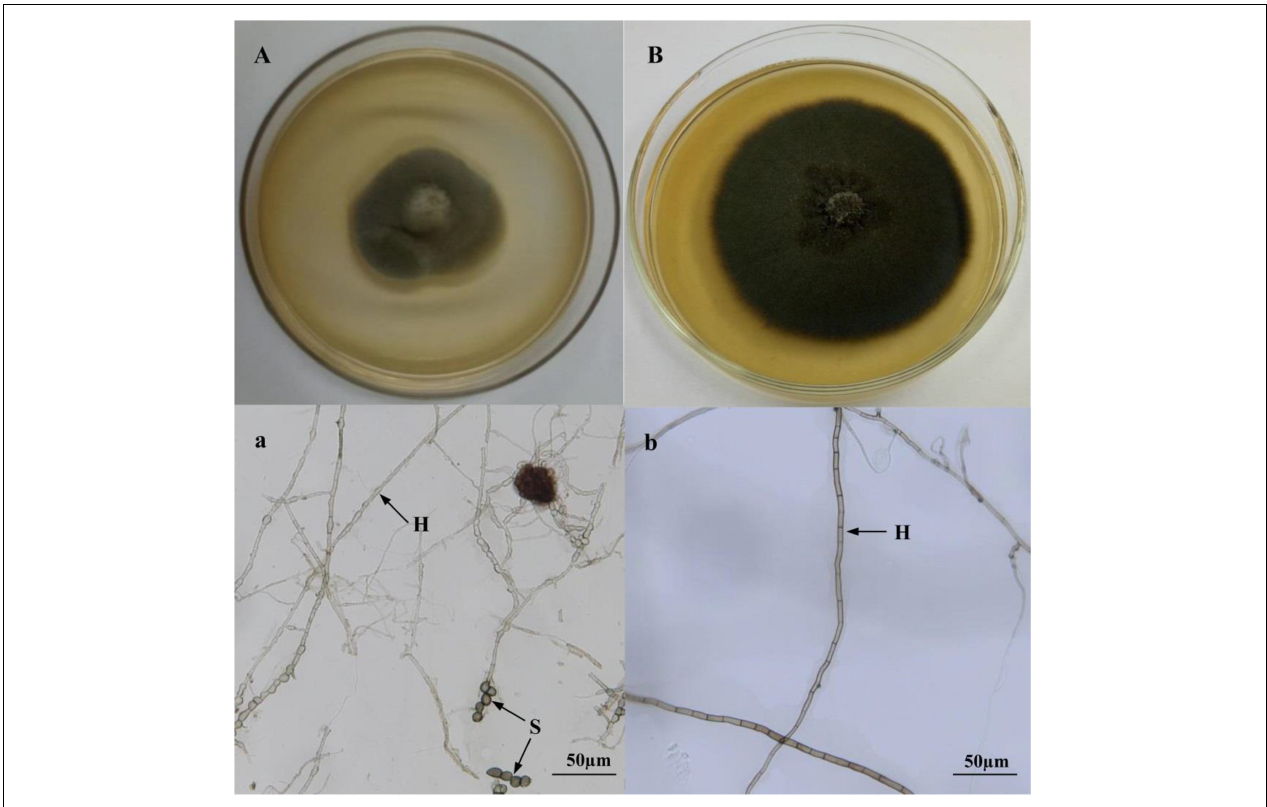
FIGURE 1 | Colonies of endophytic fungi isolated from the roots of liquorice (A,B) . Microscopic morphology of endophytic fungi (a,b) (bars = 50 mm). A,a : Acrocalymma vagum ; B,b : Paraboeremia putaminum . Arrows indicate: H, DSE hyphae; S, DSE spores.